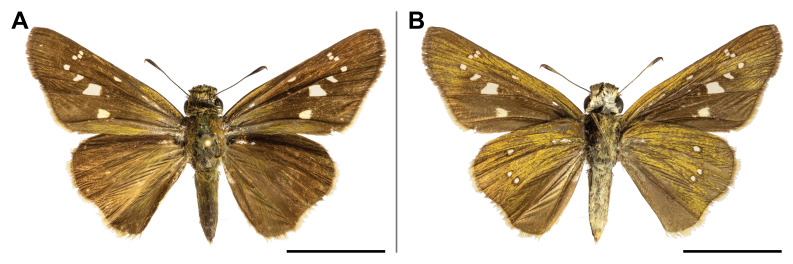
Borbo
borbonica (Boisduval, 1833). A. dorsal view; B. ventral view. The scale bar represents 1 cm.